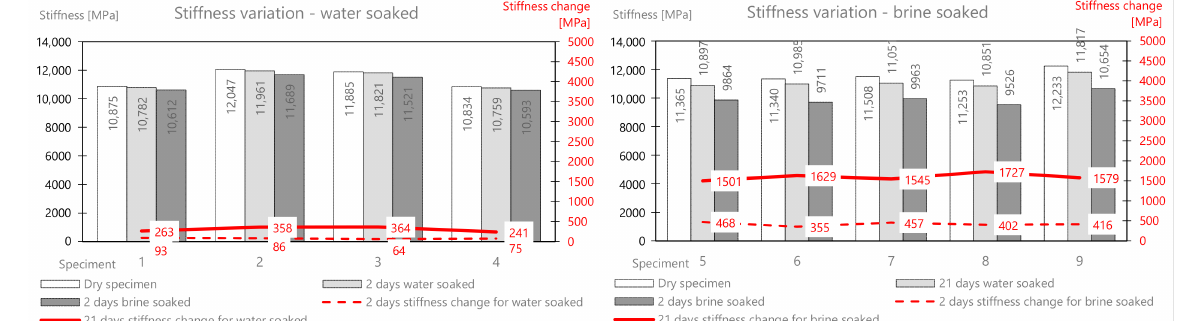
Figure 10. ACWMS22(HIMA) mix stiffness variation via water and brine